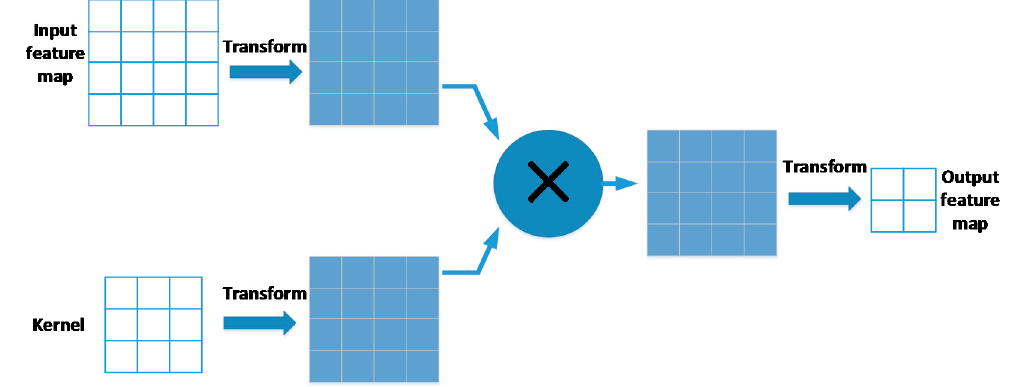
Figure 9. Dataflow of the convolution based on the Winograd algorithm.